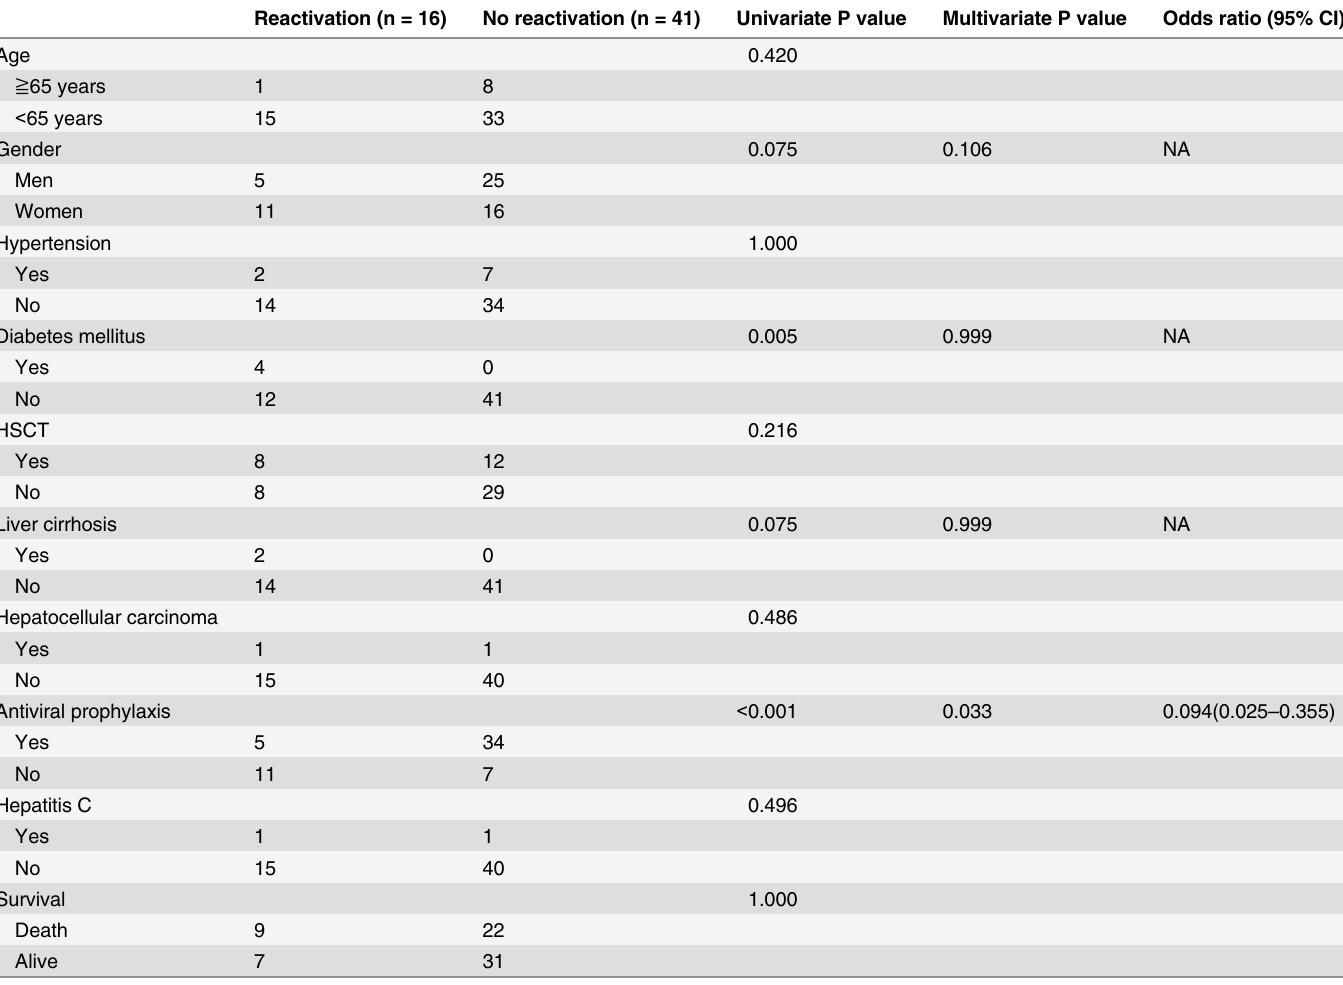
Table 3. Risk factors for hepatitis B reactivation in the subgroup of AML patients with positive HBsAg (n =